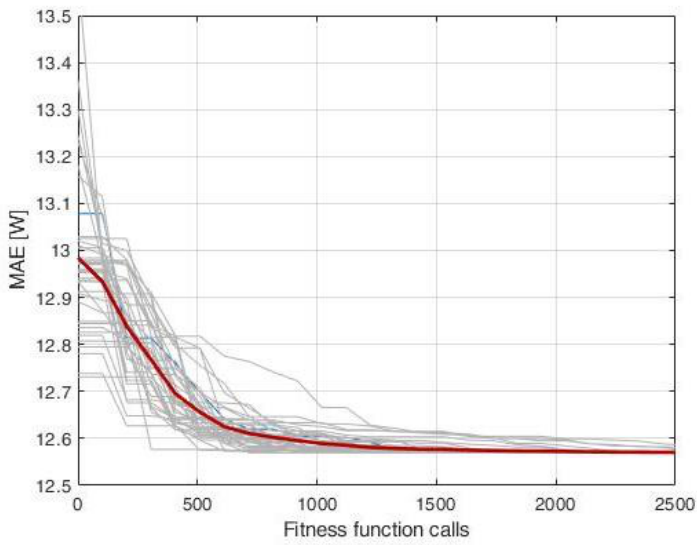
Figure 3. Convergence curves with 20 training days. The thicker red line corresponds to the average converge, while the gray lines represent the 40 independent trials